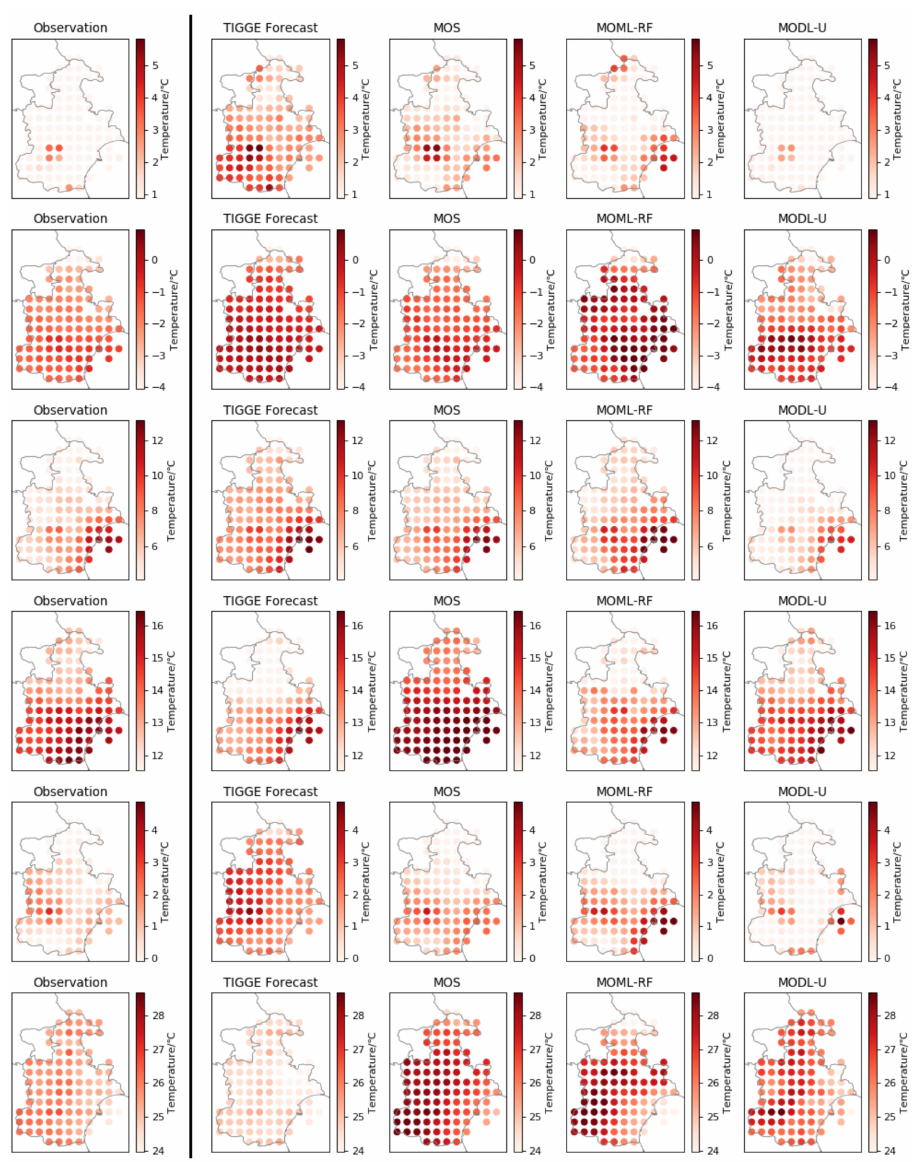
Figure 13. 2 m air temperature forecast visualization comparison figure. The figure visualizes the observation results of 2 m temperature and the forecast results of di ff erent forecast models at six di ff erent time steps. Each row of pictures corresponds to a temperature field at a time step. From left to right is the observation field, TIGGE forecast field, MOS forecast field, MOML-RF forecast field and MODL-U forecast field. Each dot on the subgraph represents the temperature of a valid forecast grid point. The shade of the color indicates the level of